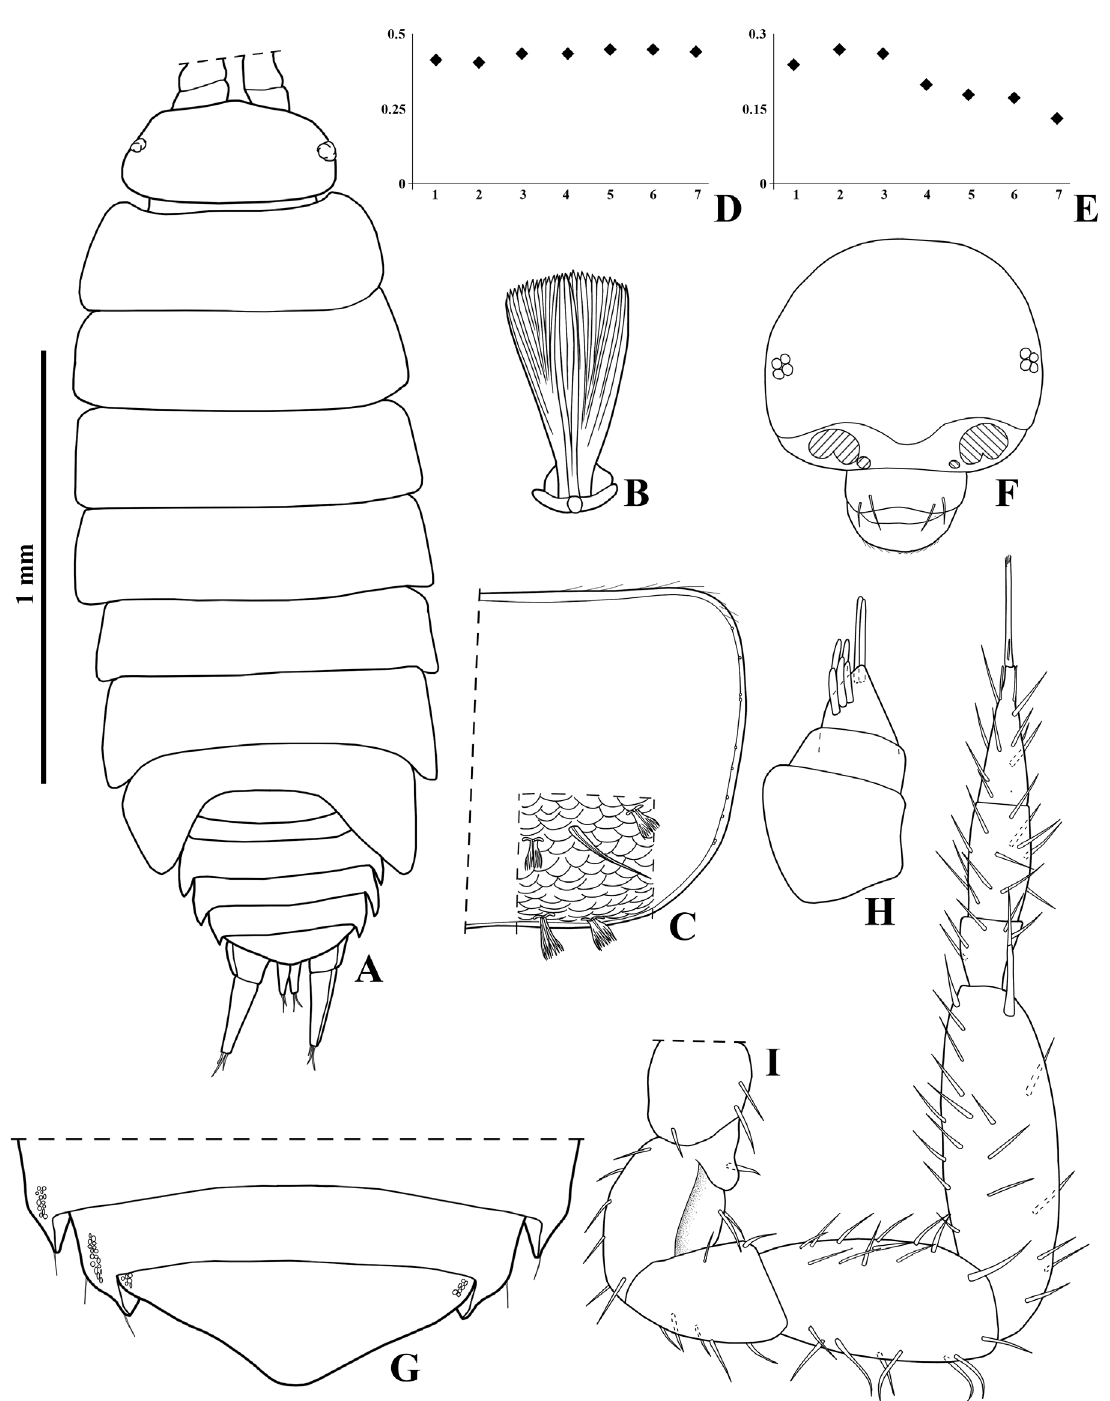
Fig. 8. Metaprosekia igatuensis Campos-Filho, Fernandes & Bichuette sp. nov., ♀, paratype (LES 6349). A . Habitus, dorsal view. B . Dorsal scale-seta. C . Pereonite 1 epimeron, dorsal view. D . Noduli laterales d/c coordinates. E . Noduli laterales b/c coordinates. F . Cephalon, frontal view. G . Pleonites 4–5 and telson. H . Antennula. I .